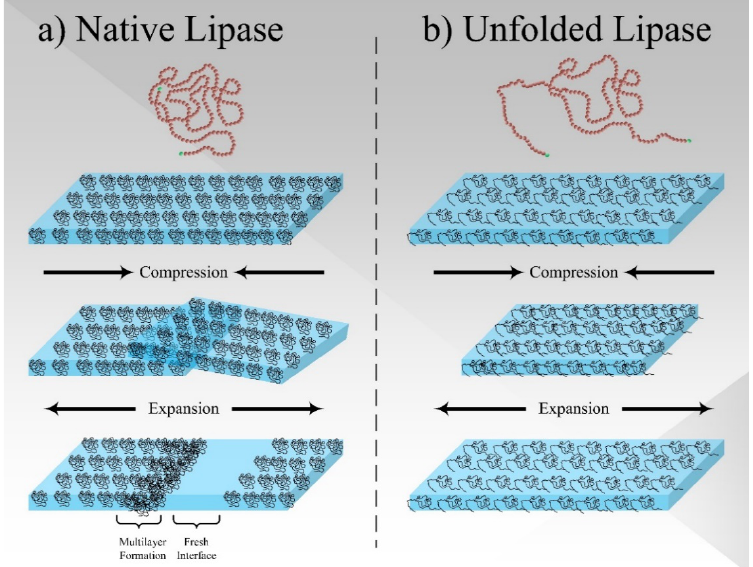
Figure 9. Schematic representation of the suggested mechanism for the high-amplitude compression deformation of the native and unfolded lipase adsorbed layers after aging.